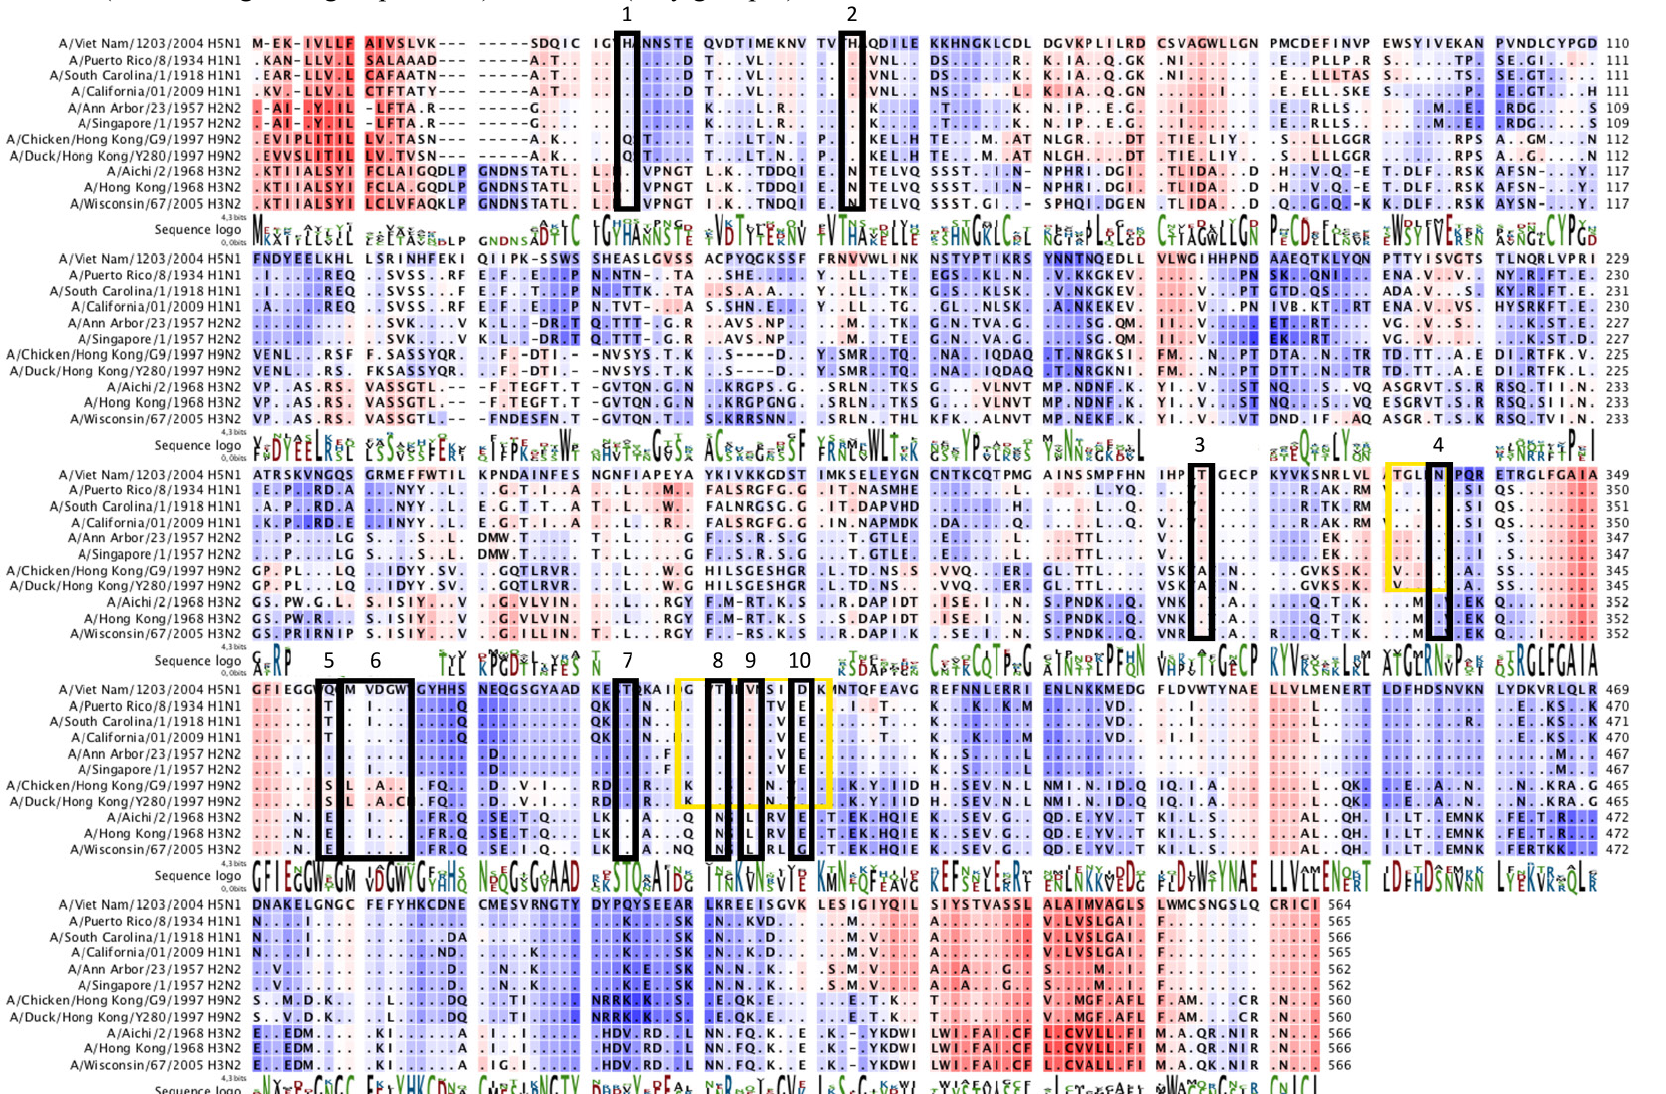
Figure 3. Multiple sequence alignment: sequence logo shows amino acid conservation. The sequence hydrophobicity profile is indicated by gradient color (red most hydrophobic) in background, black and yellow boxes underline two example of conserved epitopes belonging respectively to PN-SIA28 (neutralizing both group1 and 2) and C179 (only group